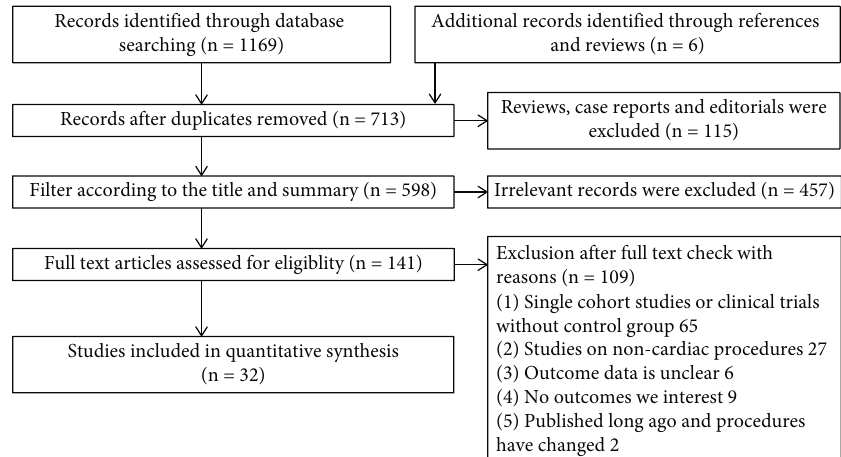
Figure 1: Flow diagram for study identi fi cation and